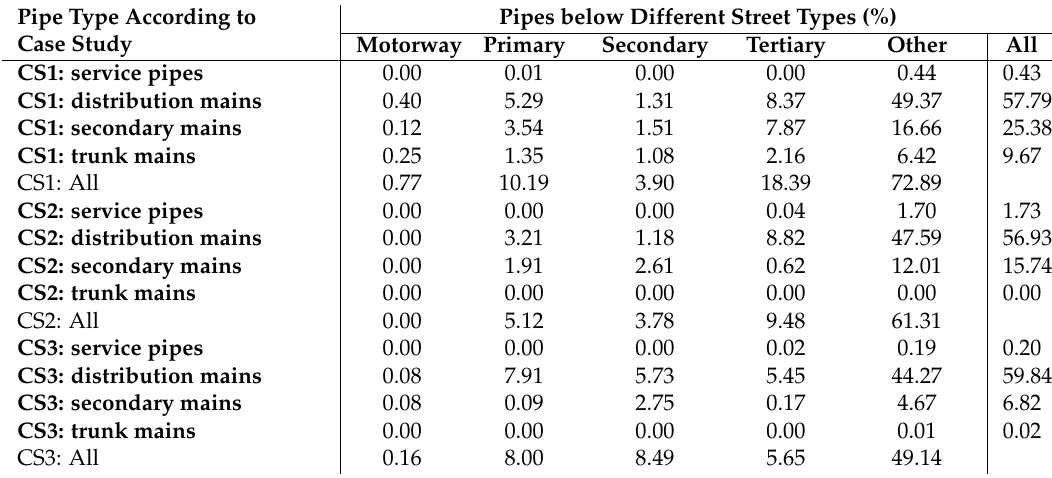
Table A1. Pipe types in correlation with street types.